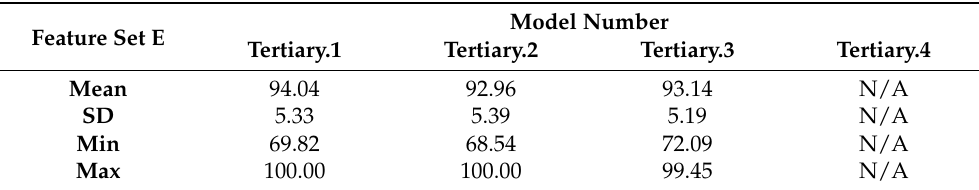
Table 10. A summary of Feature Set A with each model for the tertiary classification problem, tested using leave-one-out cross-validation. The mean, standard deviation (SD), minimum and maximum values for each model number are also shown. Feature Set